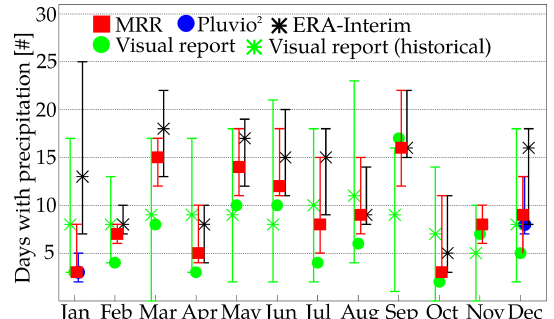
Figure 10. Precipitation occurrence at the daily scale. The er- ror bars (where applicable) come from the use of a threshold of 0.001mmd − 1 (upper limit), and 1mmd − 1 (lower limit), while the central points are calculated with a threshold of 0.28mmd − 1 fol- lowing the threshold of Palerme et al. (2014). The bars of the his- torical visual reports indicate instead the minimum and maximum occurrences in the period 1981–2015.